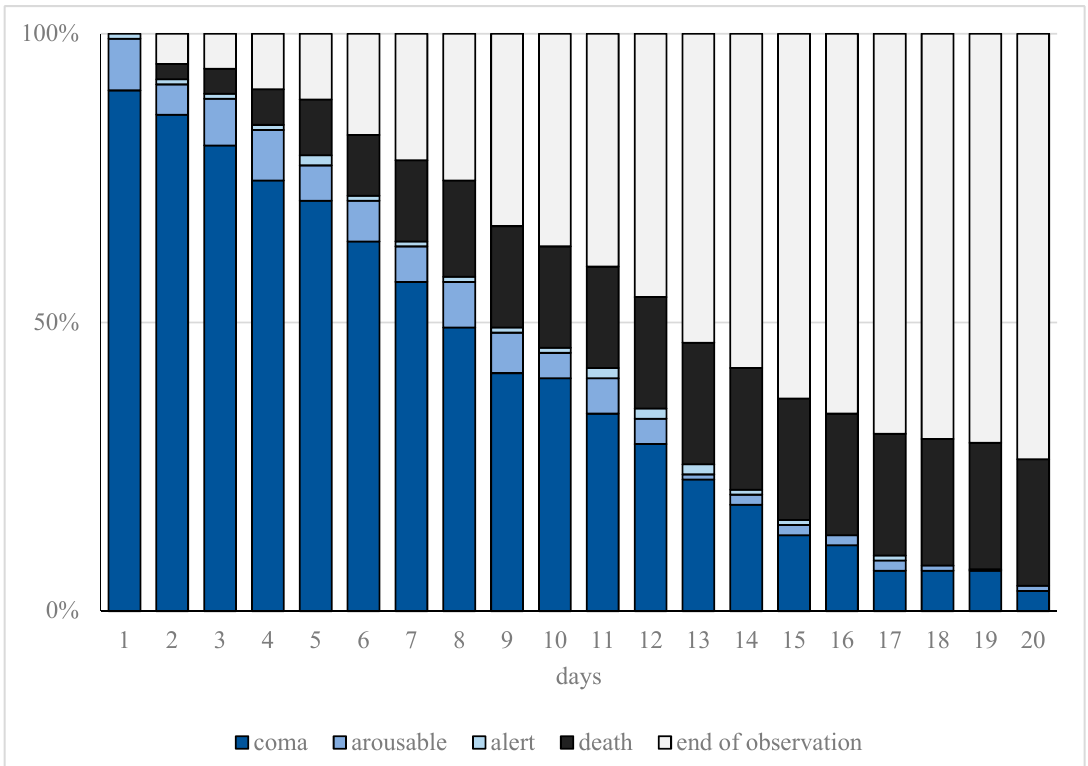
Figure 2. Cumulative frequency of observed sedation depth. Progression of observed sedation depth and deaths within the first 20 days of treatment in patients with moderate or severe COVID- 19-related acute respiratory distress syndrome (CARDS) requiring mechanical ventilation. The representation of sedation depth (assessed on the Richmond Agitation Sedation Score (RASS)) is illustrated represented as coma (ultramarine blue, RASS ≤ − 3), arousable (blue, RASS = − 2), or alert (light blue, RASS ≥ − 1). Furthermore, end of observation is represented for death (black) and tracheostomy or extubation (gray).